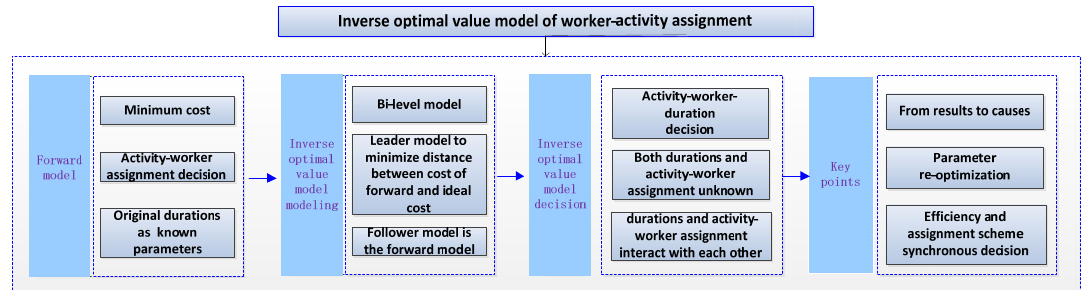
Figure 2. Transformation ideas of the inverse optimal value method.